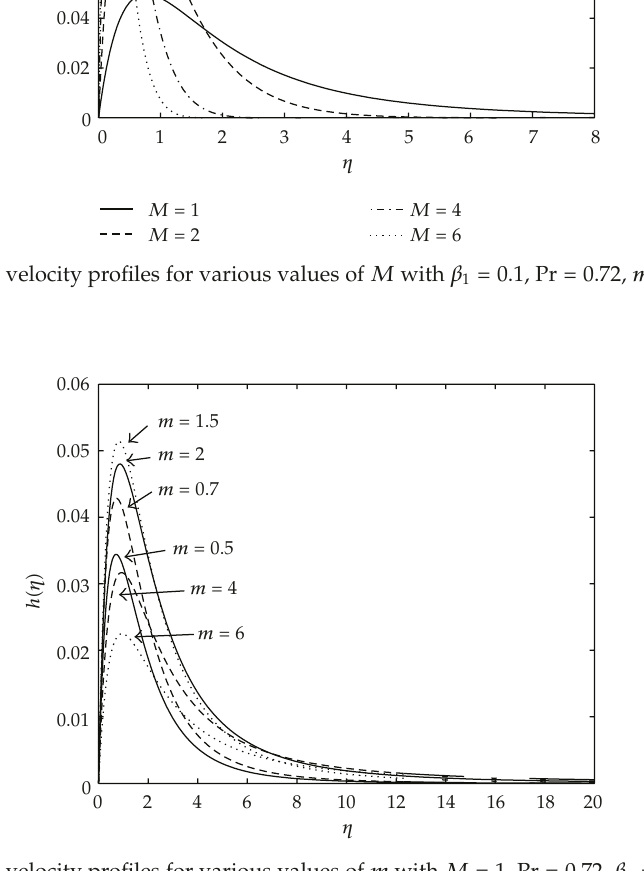
Figure 8: Transverse velocity profiles for various values of m with M (cid:5) 1, Pr (cid:5) 0 . 72, β 1 (cid:5) 0 . 1, β 2 (cid:5) 0 . 1, and S (cid:5) 0 . 8